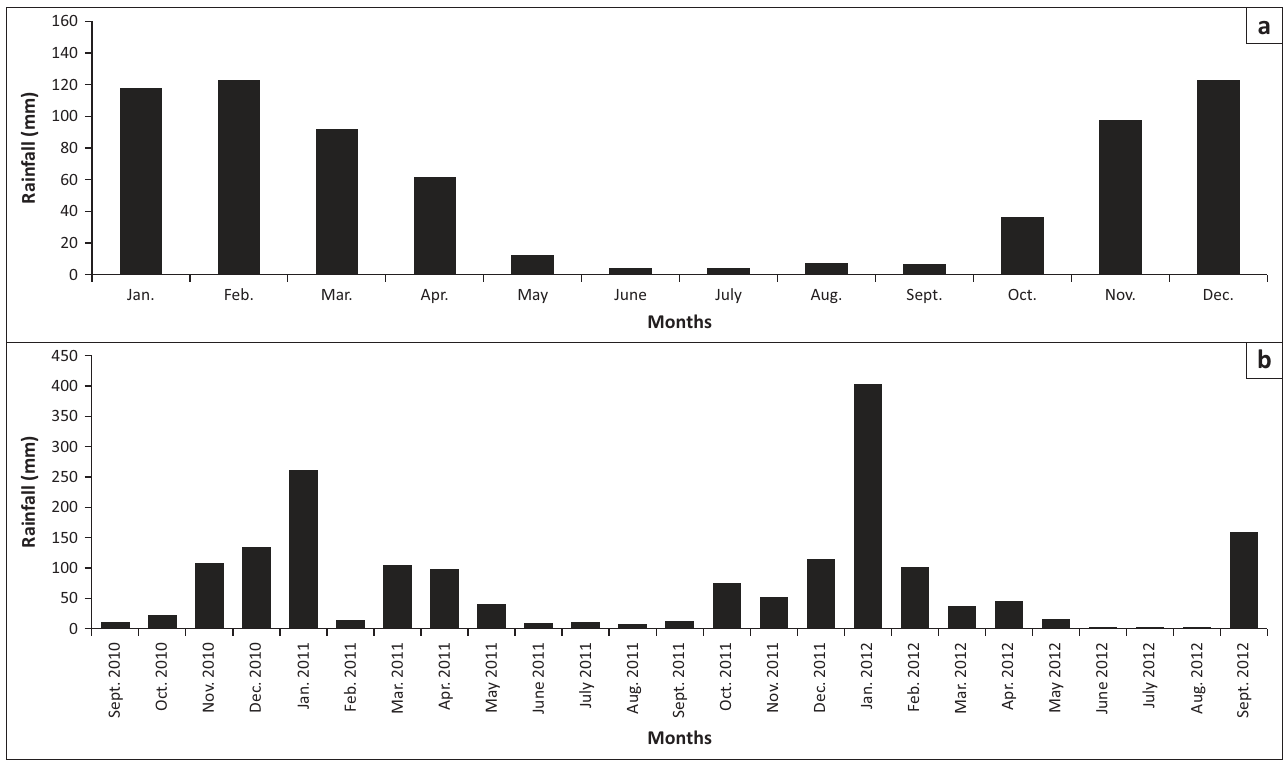
FIGURE 1: (a) Long-term mean monthly rainfall distribution (1992–2010) for the Wits Rural Facility and (b) cumulative monthly rainfall data for the duration of the study period (September 2010 – September 2012). January 2012 received exceptionally high amounts of rainfall compared to other January figures for the past 18